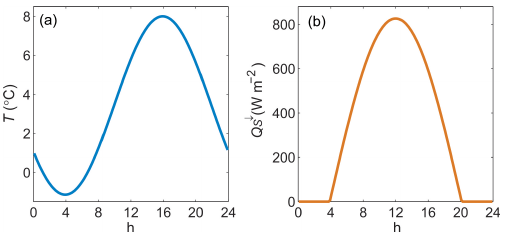
Figure 1. Idealized diurnal cycles of (a) temperature and (b) incom- ing shortwave radiation used in the energy balance model. These two examples are for a sample day, 1 July 2010, parameterized from daily minimum and maximum temperature in (a) and day of year plus mean daily incident shortwave radiation in (b)